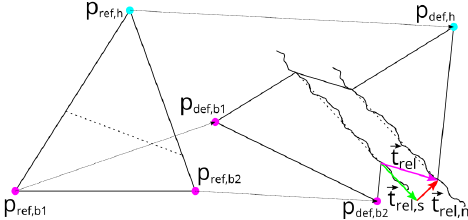
Figure 2. Scheme for the triangle split, reference state on the left, deformed on the right. Based on (Liebold et al.,